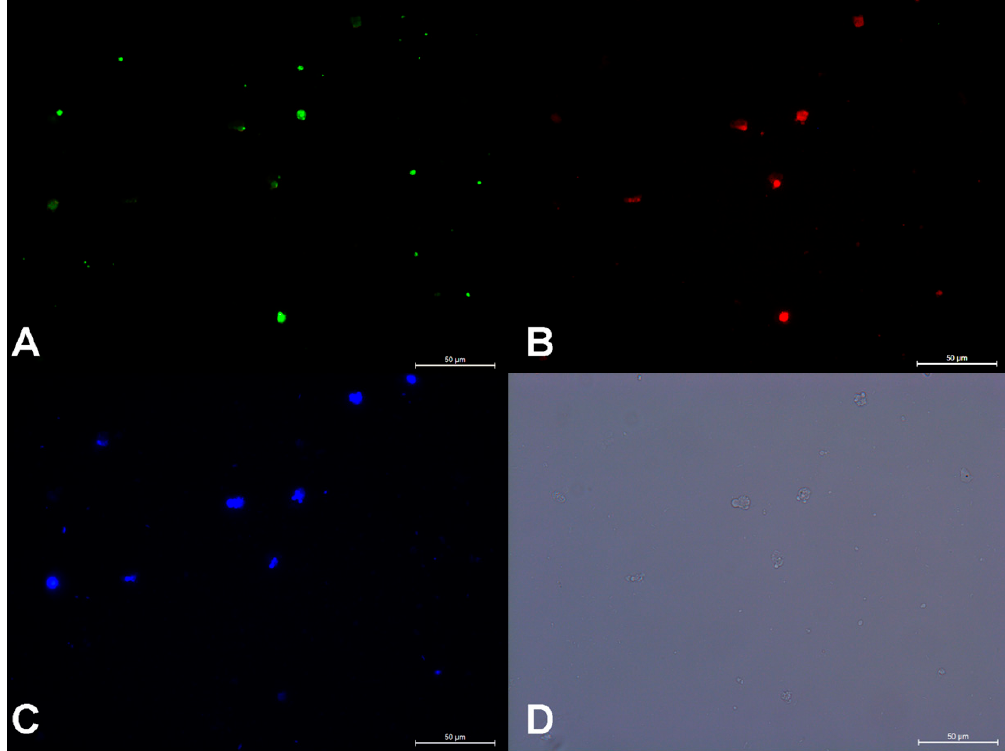
Figure 2. Immunofluorescence showing co-localization of neonatal cells at 10-days culture. Gonads were digested with trypsin and cultured at 21 °C in L-15 medium and 10% fetal bovine serum (FBS) ( v/v ). Cells were stained green for BrdU protein ( A ), red for Vasa protein ( B ) and blue for 4',6-diamidino-2-phenylindole (DAPI) ( C ). ( D ) White light.